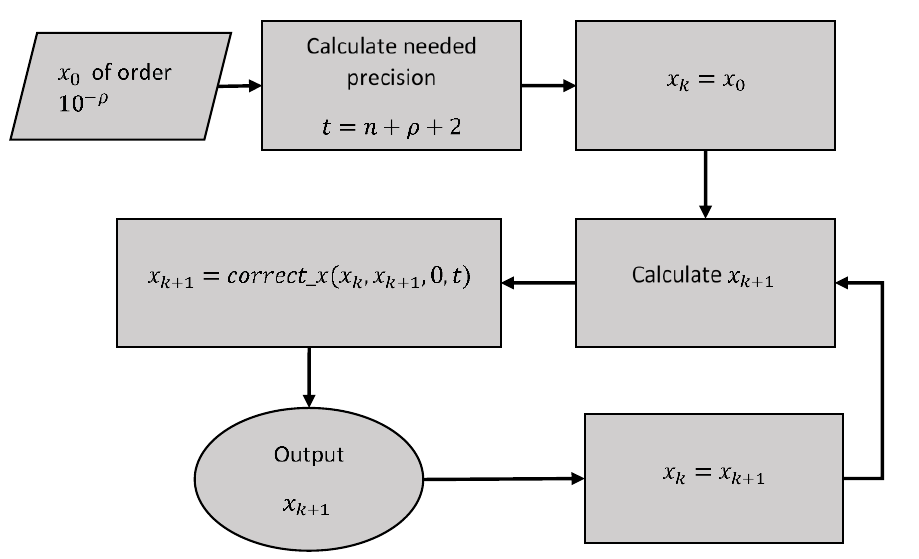
Figure 2. The chart of the entire flow of the Bernoulli map, which generates finite precision error free results, for tenths of millions of iterations.